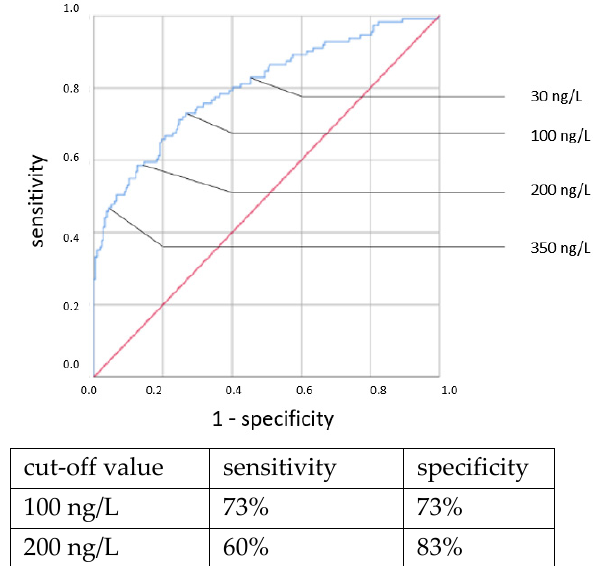
Figure 2. IL-6 concentration. Clinical EOS.